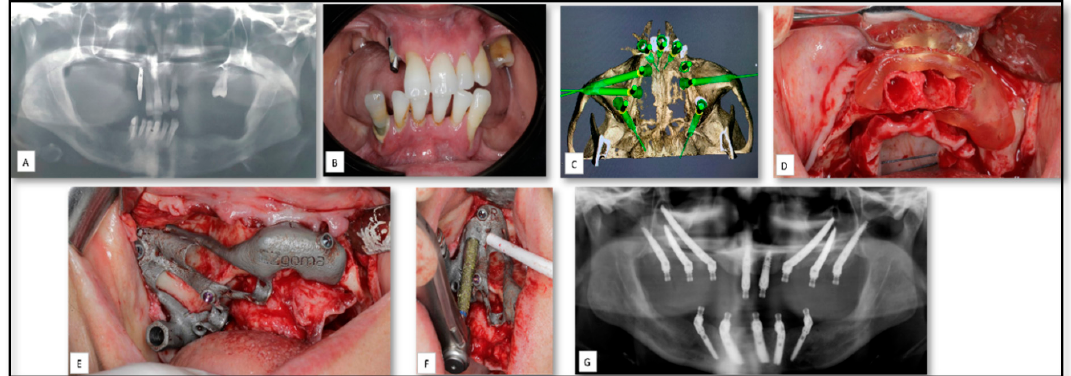
Figure 2. ( A ) and ( B ) Pre-operative panoramic and clinical view of partially edentulous atrophic posterior maxilla and maxilla. ( C ) Implants planned based on the prosthetic needs. ( D ) Cutting guide for alveoloplasty before implants placement. ( E ) The installation of the created surgical guide. ( F ) Implant osteotomy guided by the surgical guide. ( G ) Post-operative panoramic view showed the implants opposition as planed preoperatively.